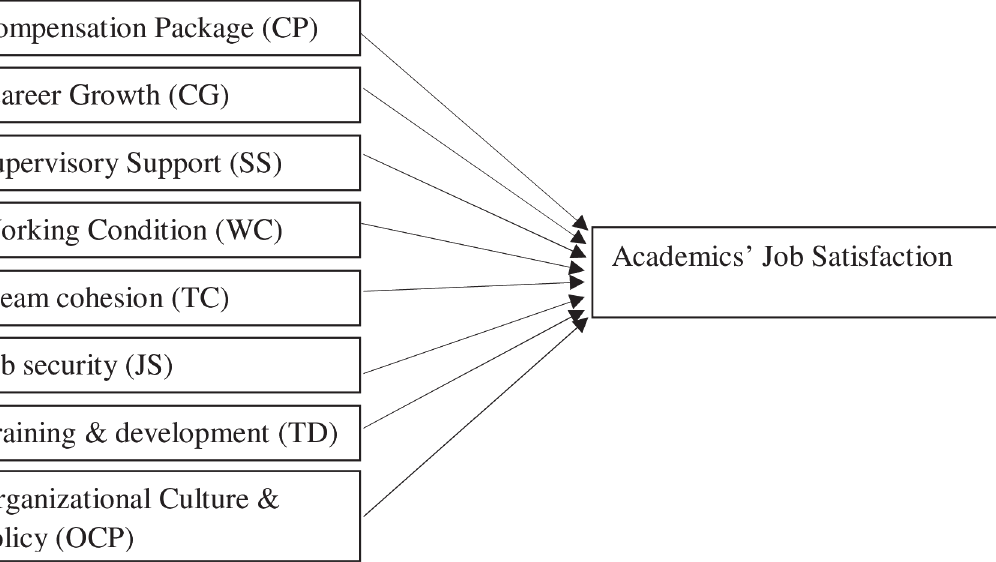
Fig 1. Conceptual model for academics ’ job satisfaction at private universities. This figure indicates that the eight HR and organizational factors examined influence the job satisfaction of academics at private universities in Bangladesh.